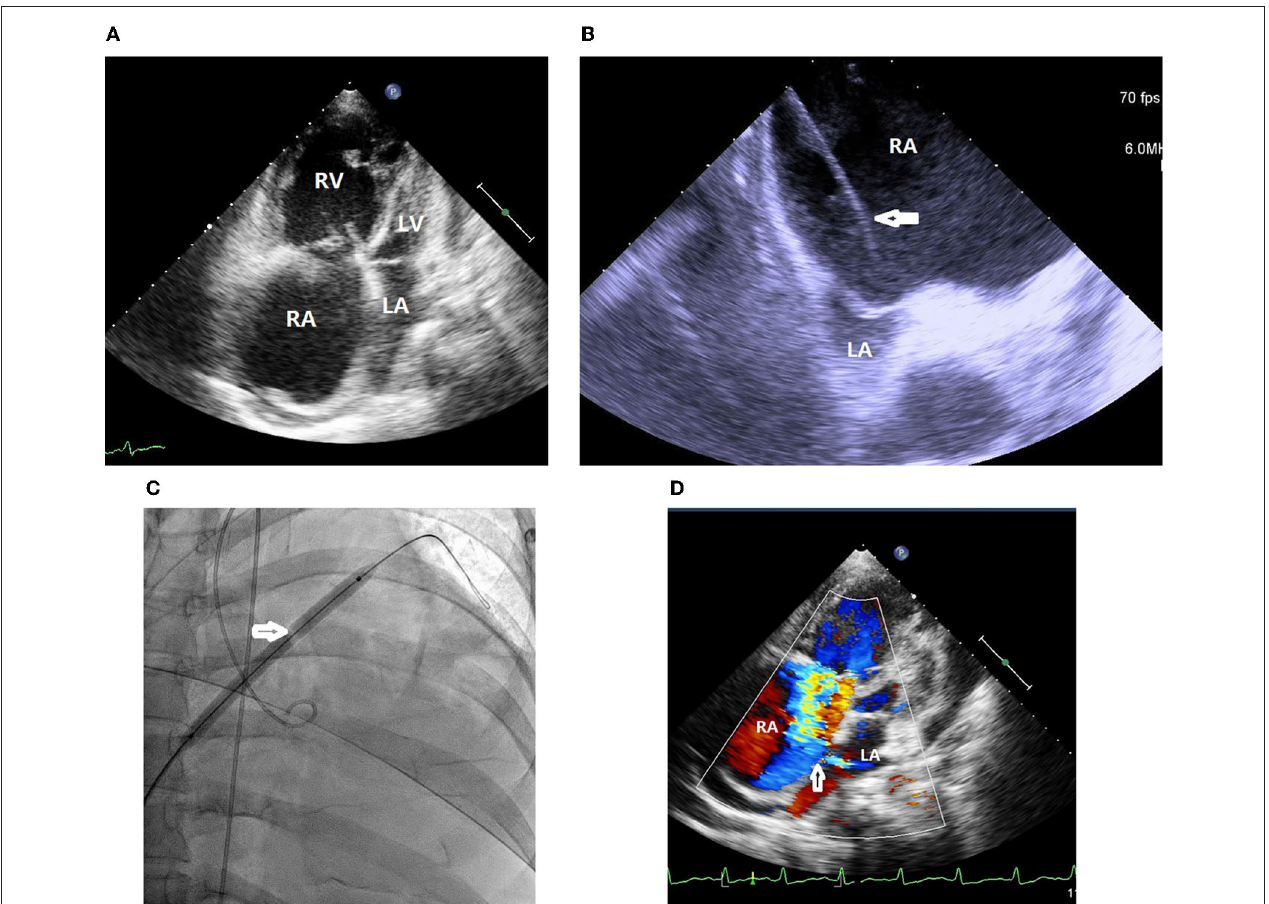
FIGURE 1 | (A) Trans-thoracic echocardiogram revealed marked dilated right atrium and right ventricle in addition to small and compressed left atrium and left ventricle. RA, right atrium; RV, right ventricle; LA, left atrium; LV, left ventricle. (B) Intracardiac echocardiogram (ICE) showed marked dilated right atrium and small compressed left atrium. A transseptal Brockenbrough needle and a Mullins sheath (white arrow) was probing the inter-atrial septum with a tenting sign. RA, right atrium; LA, left atrium. (C) The atrial septum was dilated with a 6mm × 8cm balloon (white arrow). (D) Transthoracic echocardiogram confirmed the establishment of an inter-atrial shunt from right to left (white arrow). RA, right atrium; LA, left